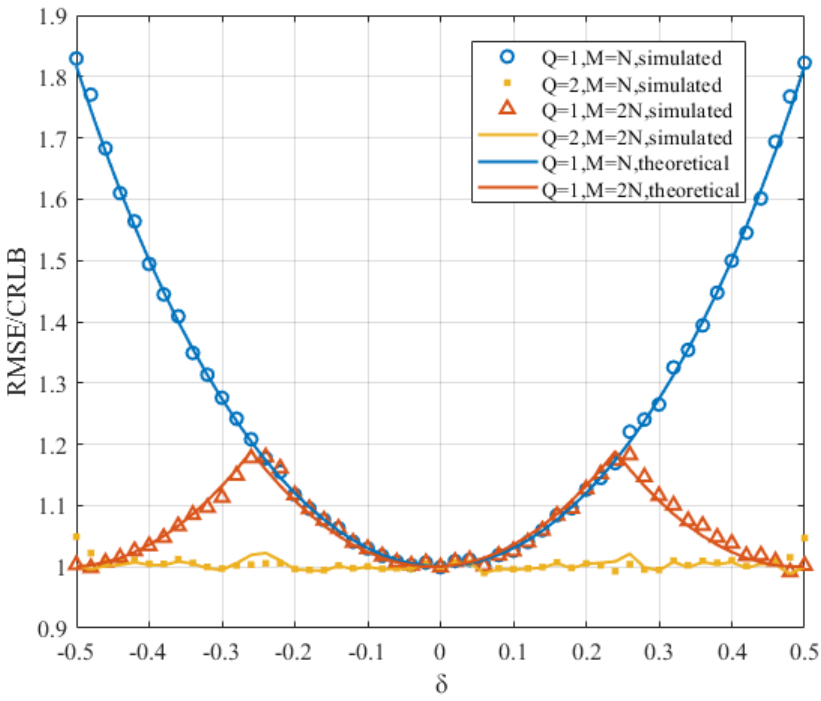
Figure 6. The RMSE/CRLB of the proposed estimator versus δ under different settings of M and Q when SNR = 0 dB and N =